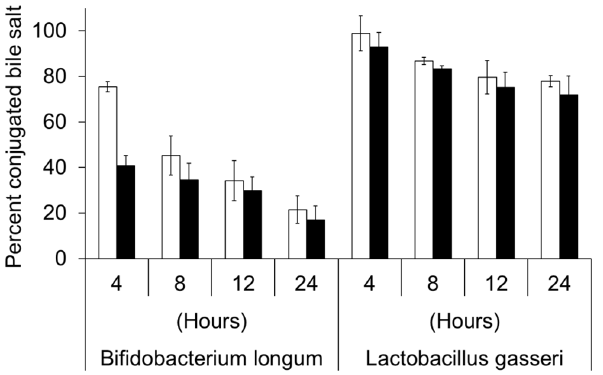
Figure 2. Stability of CamSA and taurocholate towards bile salt hydrolases. CamSA (white bar) and taurocholate (black bars) were incubated with cultures of B. longum or L gasseri . Percent conjugated bile salts were derived by dividing the intensity of TLC spots obtained at different times by the intensity of the TLC spot obtained at the beginning of incubation (time 0). Time 0 was set at 100% and is not shown for clarity. Standard deviations represent at least five indepen- dent